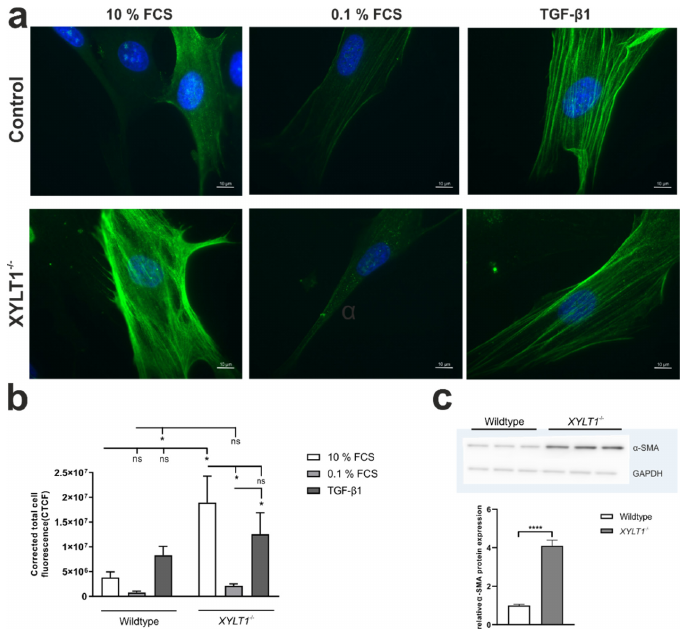
Figure 4. Quantification of α -SMA protein expression using immunofluorescence and Westernblot analysis. Wildtype and XYLT1 − / − fibroblasts were seeded (50 cells/mm 2 ) and incubated overnight. After 24 h, cells were further cultivated under standard cell-culture conditions (10% FCS) or a serum withdrawal from 10% to 0.1% FCS was performed for 24 h. Thereafter, cells were incubated with vehicle (negative control) or TGF- β 1 (5 ng/mL) for another 120 h. Cells were then fixed and α -SMA protein expression was visualized by immunohistochemistry ( a ). Cell-fluorescence was quantified by using ImageJ to calculate CTCF ( b ). For Western blot analysis, cells were cultivated for a total of 72 h in standard-cell culture medium, containing 10% FCS. Cells were then lysed and protein-concentrations were determined using a BCA-assay. 20 µ g protein/sample were separated by SDS-PAGE and subsequently transferred onto a polyvinylidene difluoride (PVDF)-membrane. Primary α -SMA antibody was diluted 1:2000. As a loading-control, we used a primary GAPDH-antibody (dilution: 1:2000). Intensities of protein-bands were quantified using ImageJ ( c ). Values represent means ± SEM. ns: not significant; * p < 0.05; **** p <